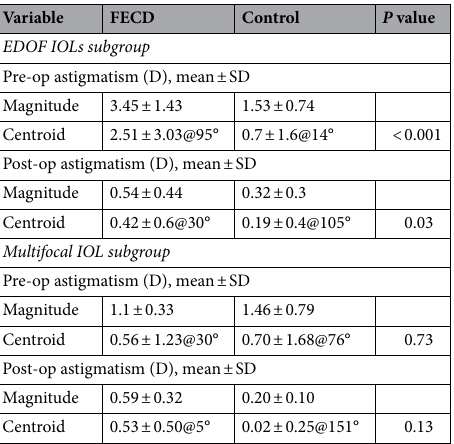
Table 5. Preoperative and postoperative astigmatism in patients with PC-toric-IOLs . D